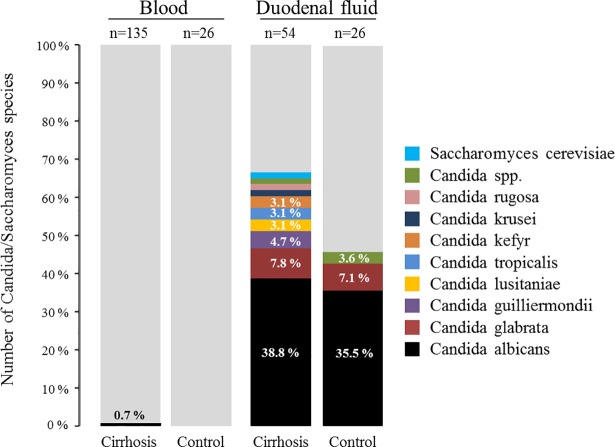
Detection of fungal species in blood and duodenal fluid of patients with liver cirrhosis and in control patients by using microbial culture techniques.The number of each sample group equals 100%. Stacked bars without percentage value correspond to 1.6%.